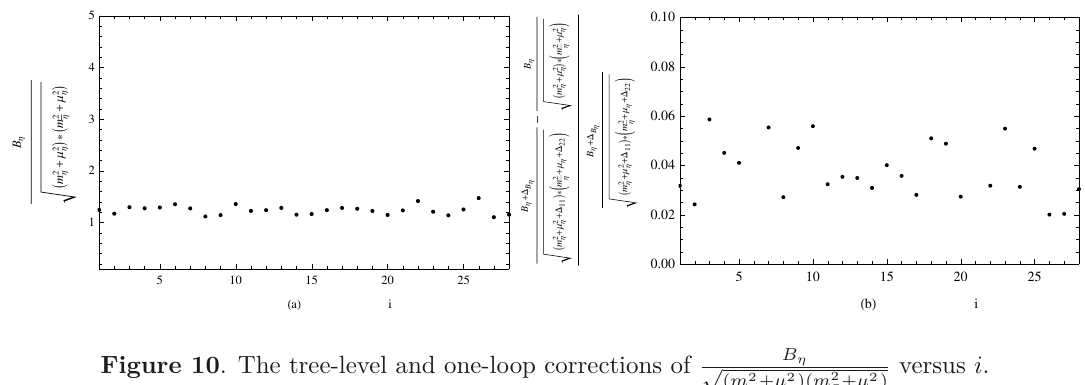
versus i 2 2 2 √ ( m 2 ¯ η + µ η + µ η )( m η )